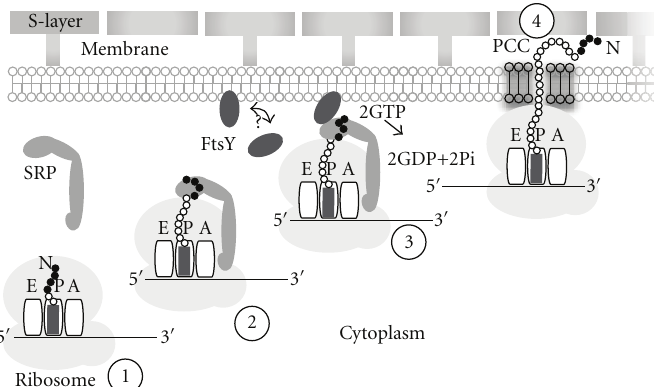
Figure 1: Hypothetical steps in the SRP-mediated targeting of archaea proteins. Step 1: A ribosome (gray, with A, P and E tRNA binding sites) in the cytoplasm translates a mRNA molecule (black, 5 (cid:2) and 3 (cid:2) ends are indicated) which encodes a N-terminal signal or membrane- anchor sequence (black dots). Step 2: As the signal emerges from the large ribosomal subunit, it is recognized by the elongated SRP and further translation may be halted. Step 3: The SRP-bound ribosome nascent chain complex (RNC) binds to free or membrane-associated FtsY (arrow). Step 4: After GTP hydrolysis, SRP has been released, translation resumes, and the targeted protein is threaded through the protein-conducting channel (PCC). The surface (S) layer, present in most archaea, is anchored to a glycerol-ether lipids-containing cell